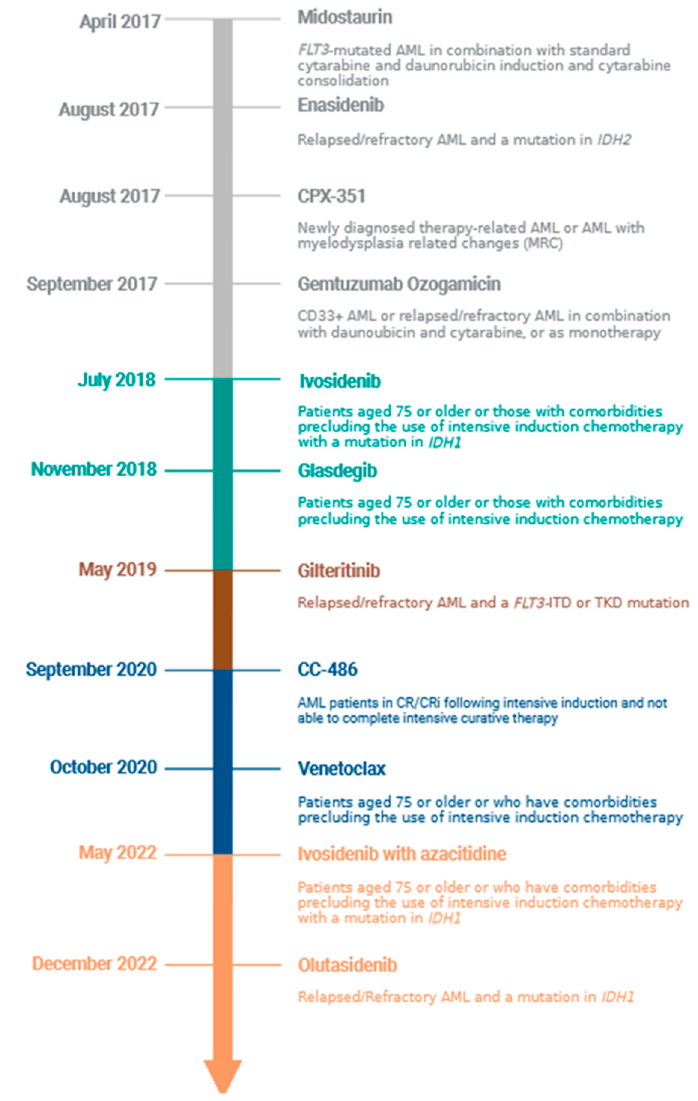
Figure 1. Timeline of FDA-approved agents for AML for specific molecular or clinical subgroups.